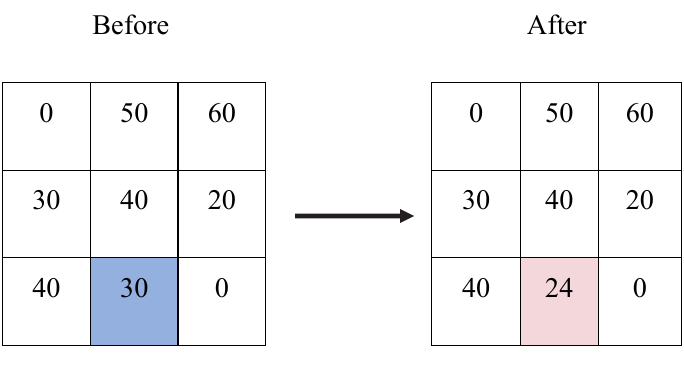
Fig. 2. The procedure of